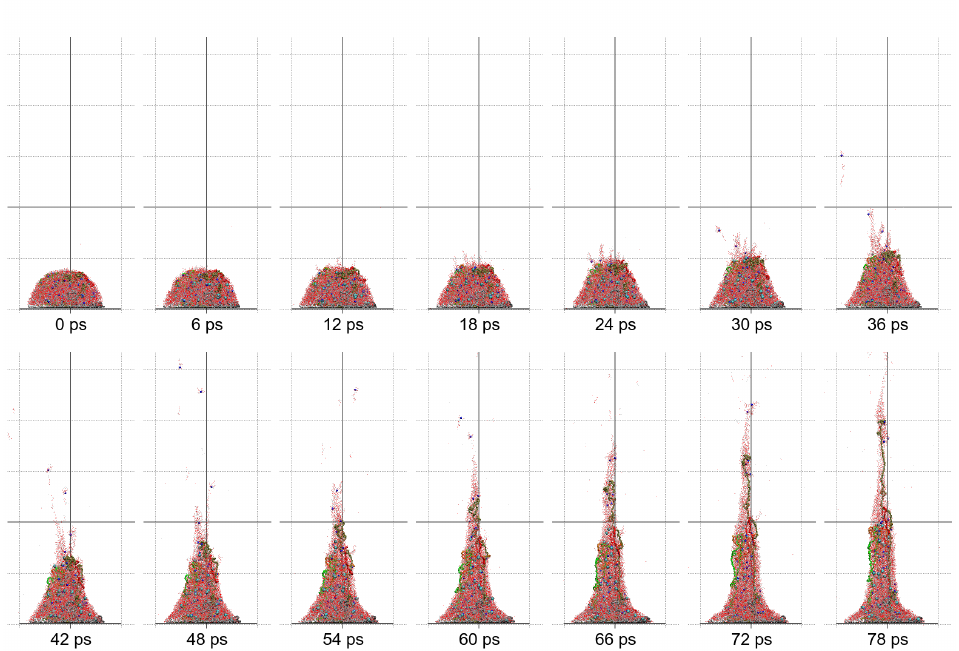
Figure 8. Snapshots from a production trajectory of the system with eight 10.55-kDa chains and 72 NaCl ion pairs under 1.5 V/nm—time evolution from 0 to 78 ps in 6-ps steps. As a visual aid, a 10-by-10-nm grid is displayed. For color scheme see Figure 3. Graphics made with Visual Molecular Dynamics [46] and ImageMagick